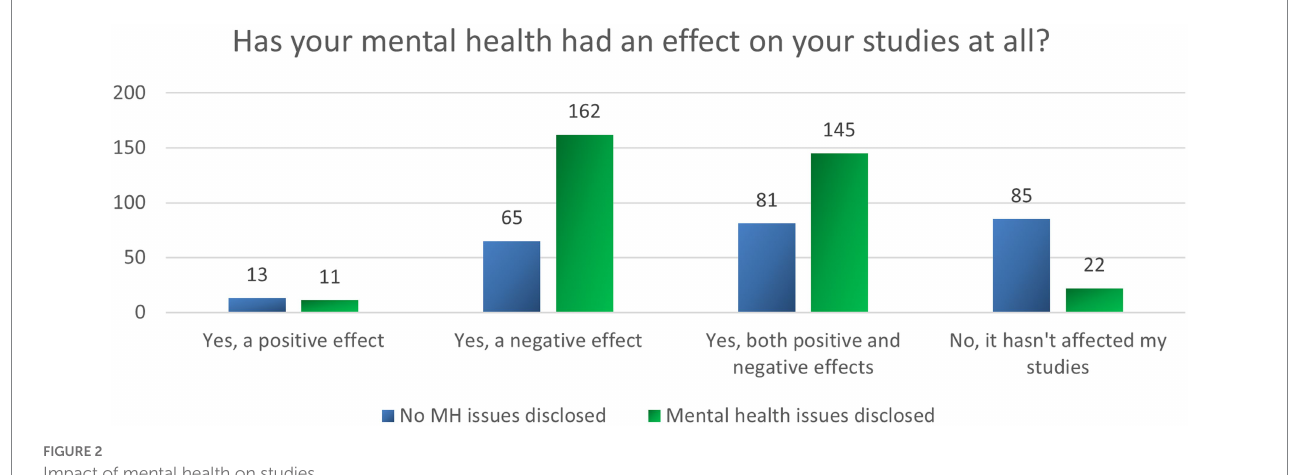
FIGURE 2 Impact of mental health on